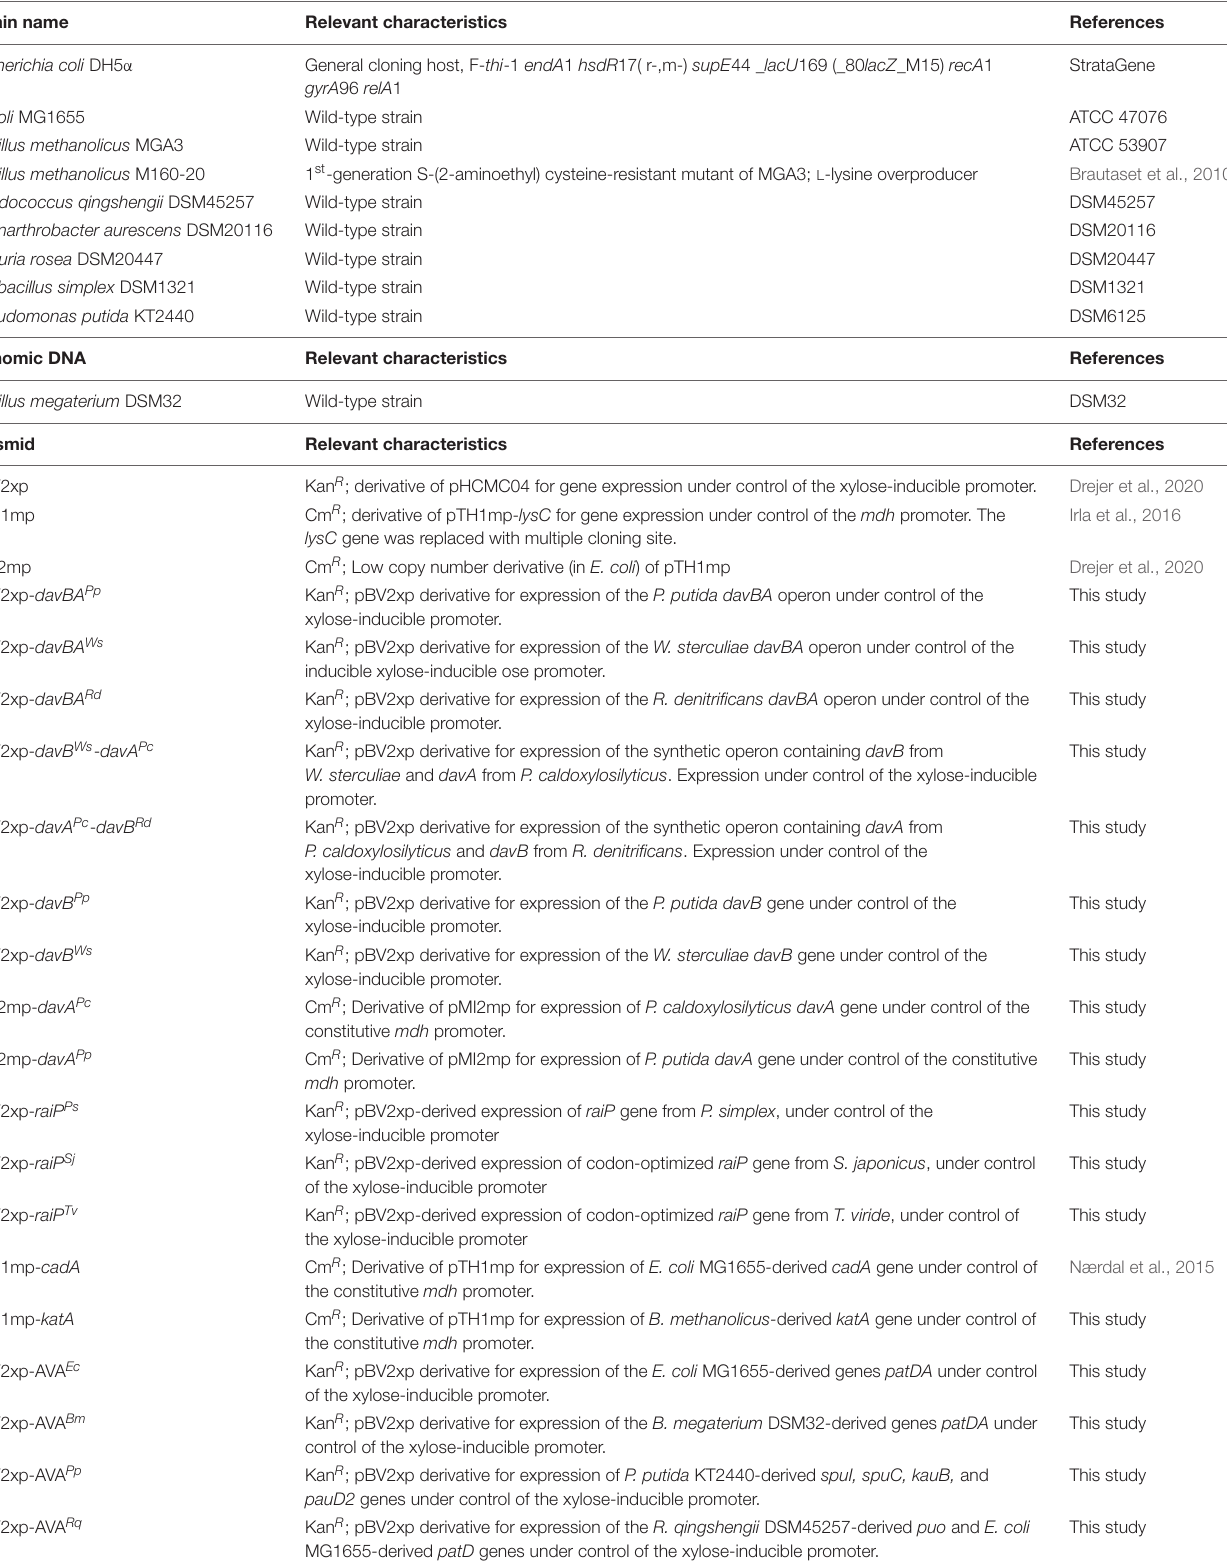
TABLE 2 | Bacterial strains, plasmids, and primers used in this